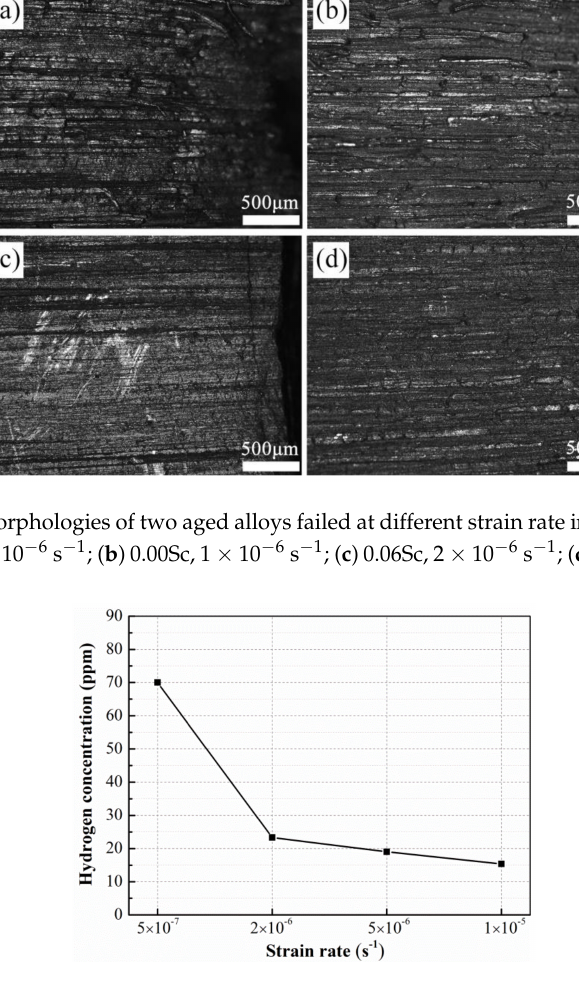
Figure 10. Hydrogen concentration near fracture location of 0.06Sc alloy tested at different strain rate in 3.5% NaCl solution at pH